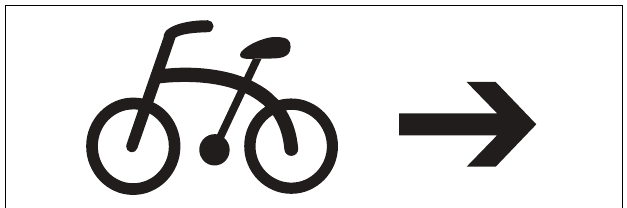
FIGURE 1 | Compositional semantics: bicycle and